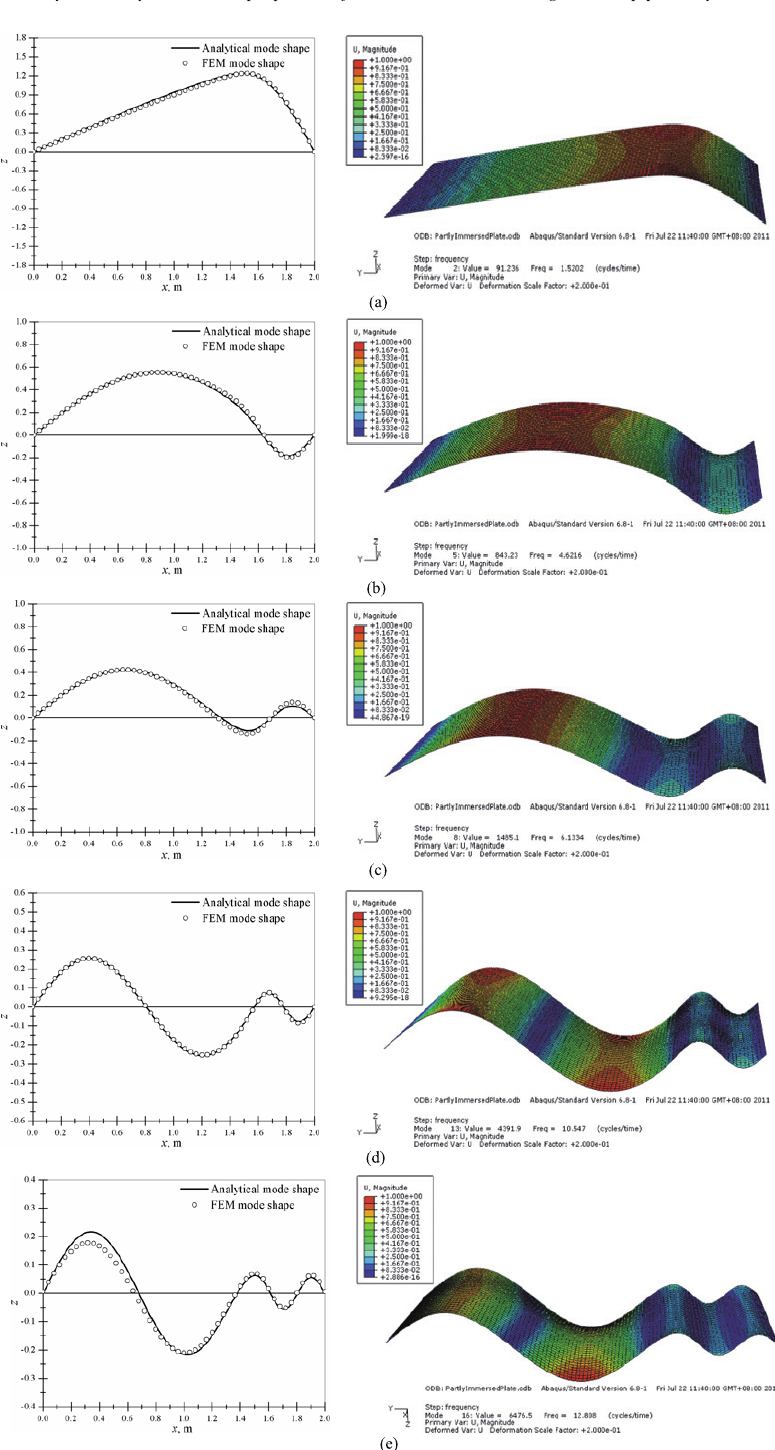
Fig. 6. Comparisons of the first five vibration modes between using SFM and FEM. (a) The first vibration mode; (b) the second vibration mode; (c) the third vibration mode; (d) the fourth vibration mode; (e) the fifth vibration